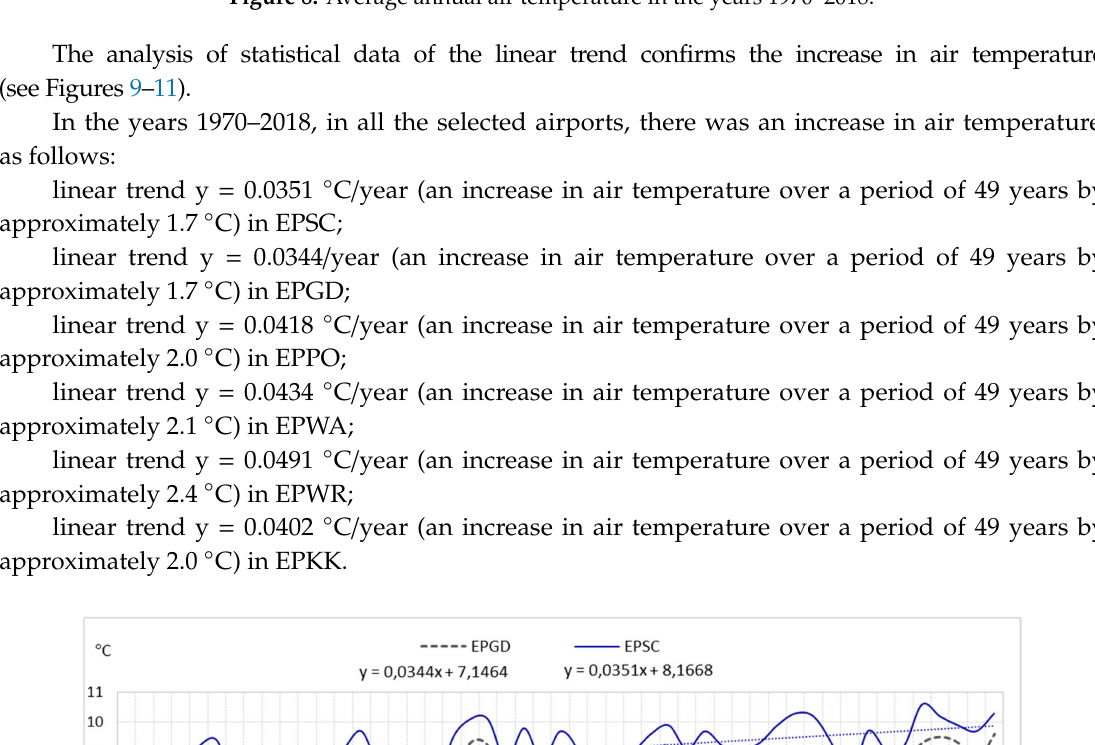
Figure 8. Average annual air temperature in the years 1970–2018.